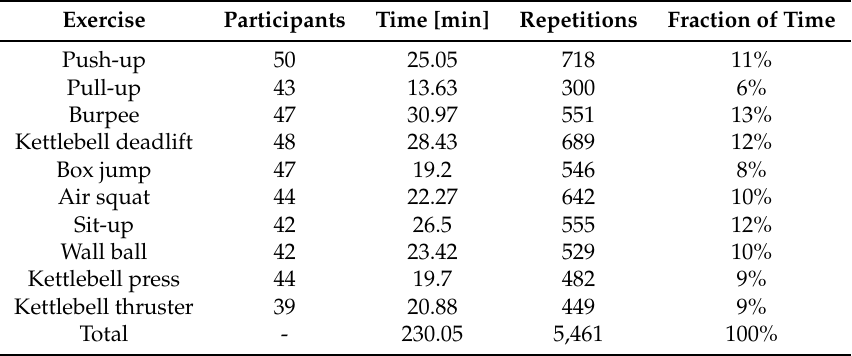
Table 2. Statistics of the collected data.